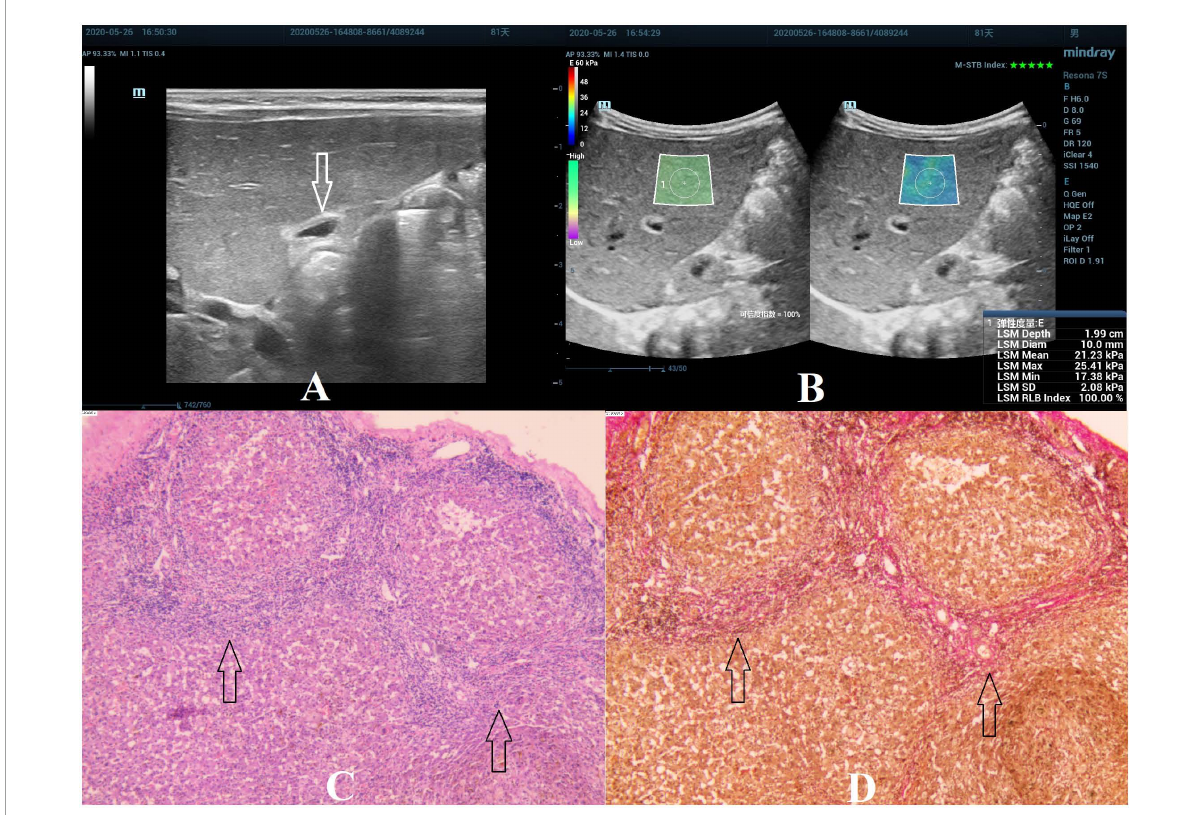
FIGURE4 Biliary atresia in an 81-day-old boy with stage F4 hepatic fibrosis. (A) Arrow indicating the gallbladder abnormality. (B) STE image showing the mean value of liver stiffness of 21.23 Kpa. (C) Hematoxylin and eosin staining (40 × magnification). The structure of the hepatic lobule disappeared, the fibrous tissue proliferated in the portal area, and the fibrous septa were formed, which surrounded the hepatocytes to form a pseudolobule. No normal central vein in the pseudolobule was found, and the structure of the hepatic sinusoids was disordered (as indicated by the arrow). (D) Van Gieson staining (40 × magnification). Collagen fibers are stained red, and the pseudolobules are more clearly displayed (as indicated by the